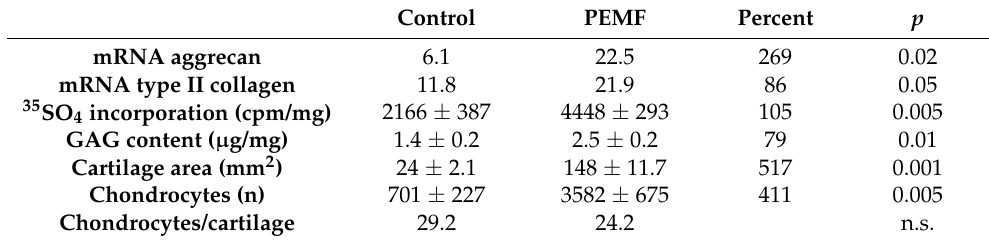
Table 1. Indices of Chondrogenesis with PEMF Exposure